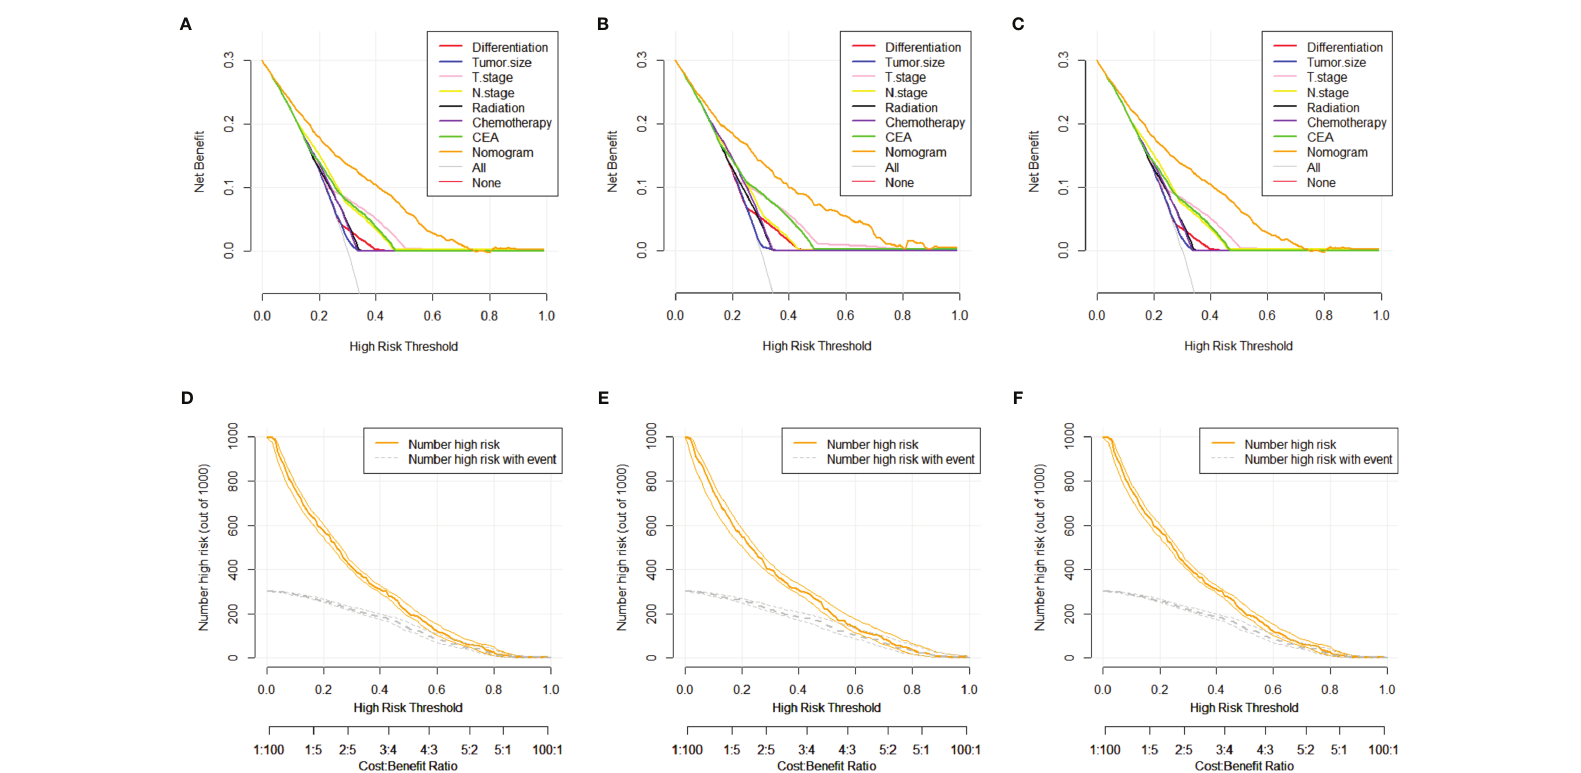
FIGURE 5 | DCA and CIC curves of nomogram for distant metastasis in training set, testing set, and validation set. (A) DCA curve of nomogram for distant metastasis in training set. (B) DCA curve of nomogram for distant metastasis in testing set. (C) DCA curve of nomogram for distant metastasis in validation set. (D) CIC curve of nomogram for distant metastasis in training set. (E) CIC curve of nomogram for distant metastasis in testing set. (F) CIC curve of nomogram for distant metastasis in validation set. DCA, decision curve analysis; CIC, clinical impact